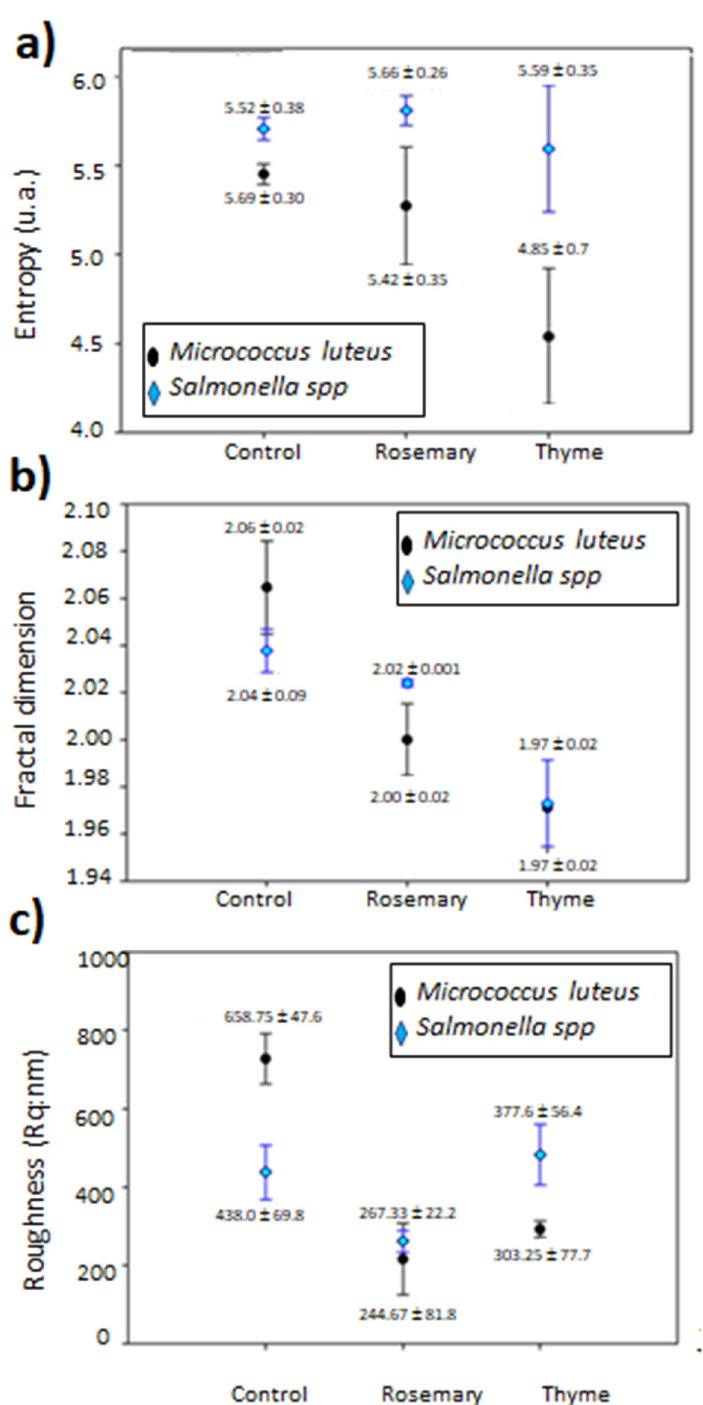
Figure 8. Atomic force micrographs image analysis on the effect of filmogenic suspensions with and without essential oils of Salmonella sp. and M. luteus. ( a ) Entropy (u.a: arbitrary units), ( b ) fractal dimension, and ( c ) roughness.